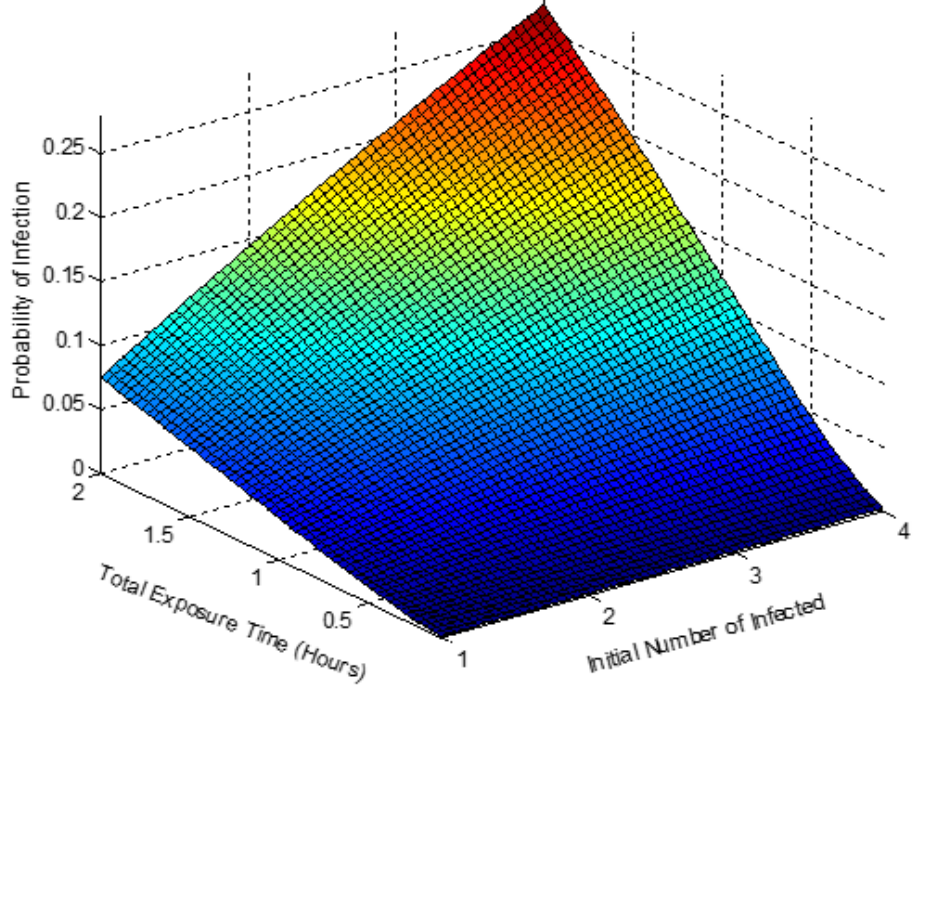
Figure 6. The probability of infection in a single train coach with 54 passengers shown as a function of the total exposure time and the initial number of